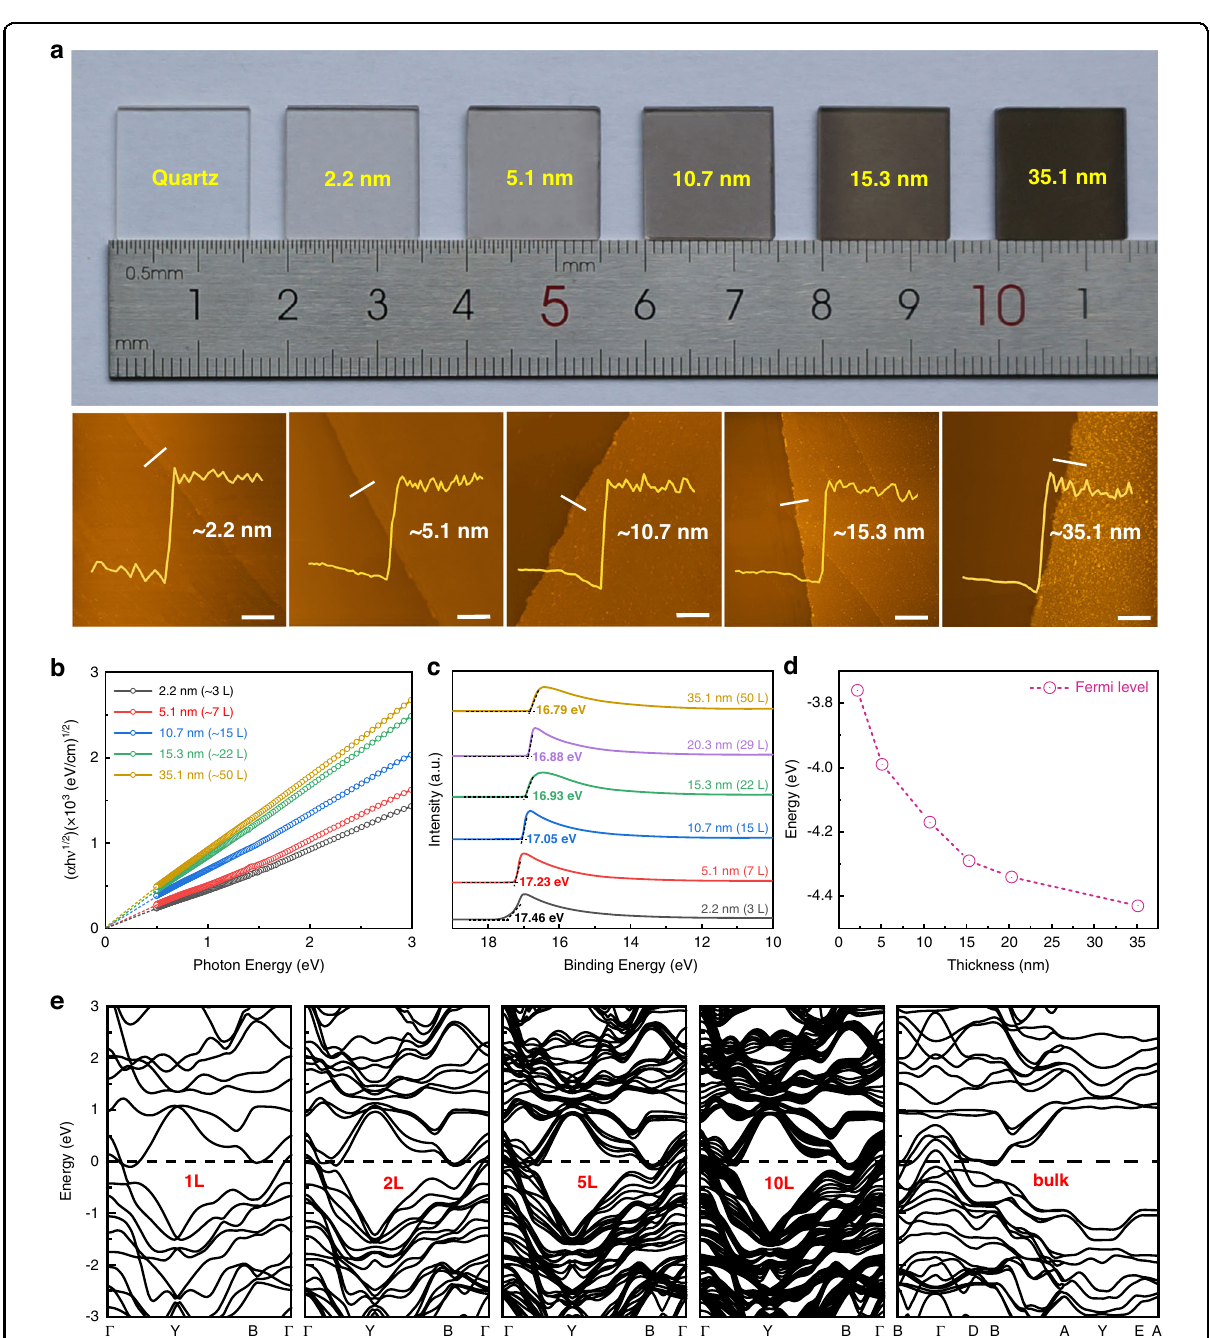
Fig. 2 Thickness control and characterization of the 2D MoTe 2 layers. a Photograph and corresponding AFM images of the 1T ʹ -MoTe 2 layers with different layer numbers grown on the quartz. Scale bar: 2 μ m. b Thickness-dependent Tauc plots of the 1T ʹ -MoTe 2 layers. c , d Secondary-electron cut-off regions and Fermi levels of the 1T ʹ -MoTe 2 layers. e Electronic band structures of the 1T ʹ -MoTe 2 layers obtained from DFT